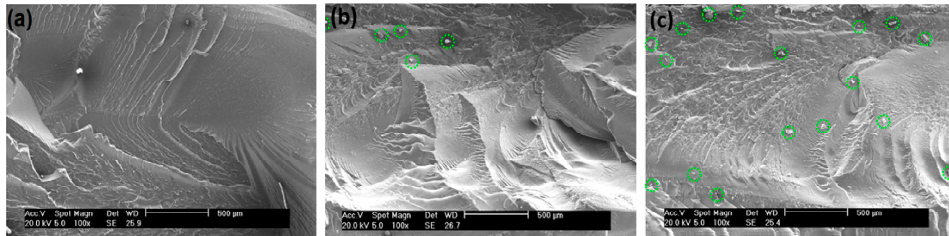
Figure 4. SEM micrographs of cryo-fractured surfaces of neat PBT and PBT/Clay nanocomposites; ( a ) neat PBT; ( b ) PBT/Clay 3.7 wt% and ( c ) PBT/Clay 4.9 wt%.